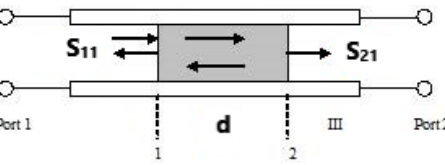
Figure 7. Diagram of in-waveguide experimental setup.